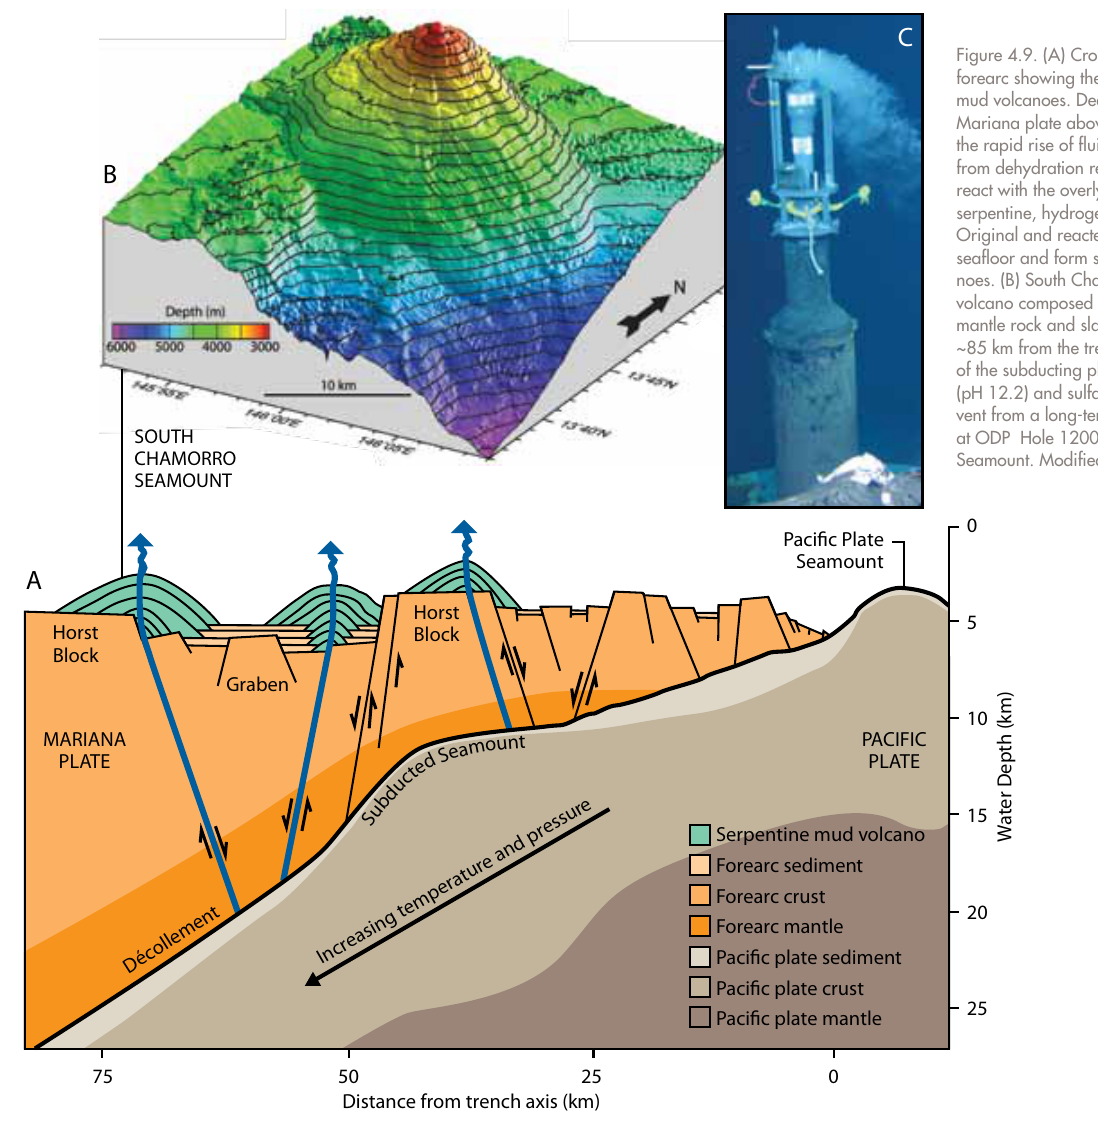
figure 4.9. (a) cross section of the mariana forearc showing the formation of serpentine mud volcanoes. deep-seated faults in the mariana plate above the downgoing slab allow the rapid rise of fluids from depth that result from dehydration reactions. ascending fluids react with the overlying mantle to produce serpentine, hydrogen, and alkaline fluids. original and reacted materials rise to the seafloor and form serpentinite mud volca- noes. (B) south chamorro seamount is a mud volcano composed of serpentinized forearc mantle rock and slab-derived schist, located ~85 km from the trench, 25 km above the top of the subducting plate. (c) highly alkaline (ph 12.2) and sulfate- and methane-rich fluids vent from a long-term borehole observatory at odp hole 1200c on south chamorro seamount. modified from Wheat et al.